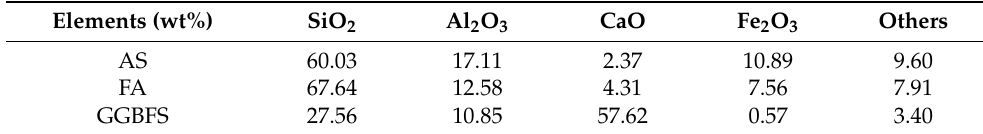
Table 1. The XRF chemical composition analysis of AS, FA, and GGBFS.